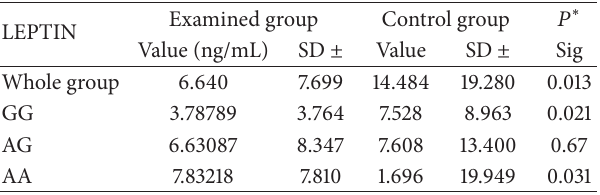
Table 4: Leptin concentration in the whole examined and control groups, accordingly to Q223R LEPR genotype. Examined group Control LEPTIN